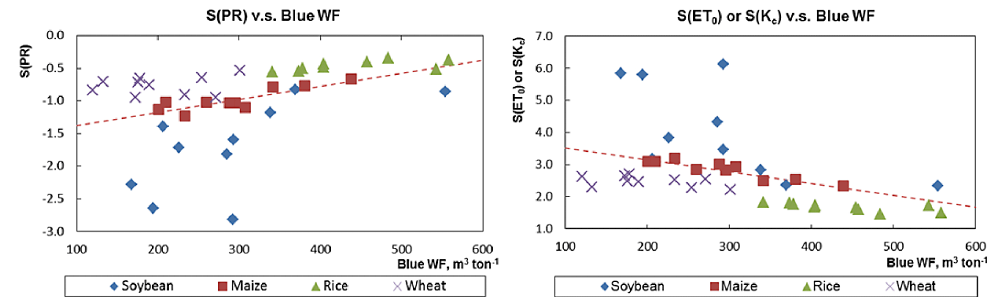
Figure 8. The slope ( S ) of the sensitivity curve for the blue WF for each crop for each year in the period 1996–2005 (vertical axis) plotted against the blue WF of the crop in the respective year ( x axis). The graph on the left shows the relative sensitivity of blue WF to PR; the graph on the right shows the relative sensitivity of blue WF to ET 0 or K c . The sensitivities to ET 0 and K c were the same. The trend lines in both graphs refer to the data for maize.